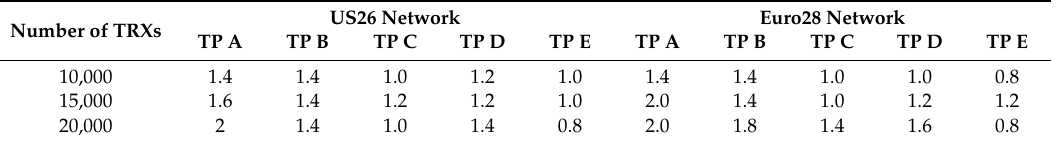
Table 2. Tuning of the SAUR algorithm—values of the scaling parameter yielding the best result as a function of di ff erent number of transponders (TRXs) and various tra ffi c profiles (TP)